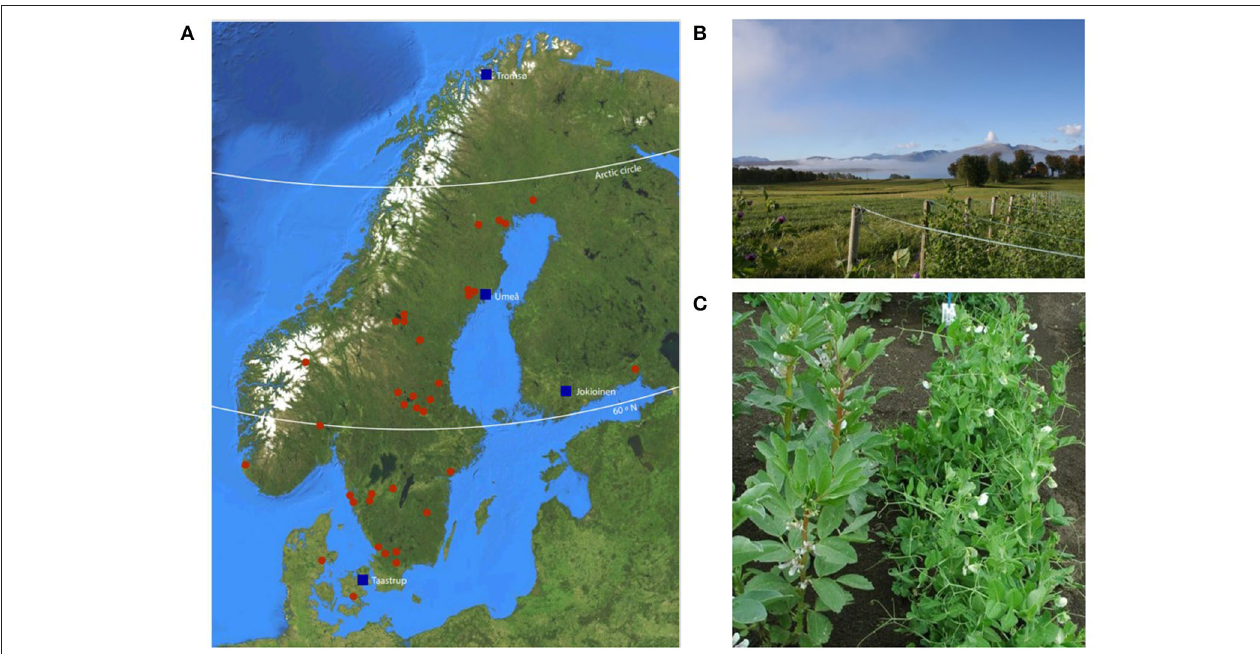
FIGURE 1 | (A) The map of trial sites (blue squares) and landrace accessions with identified locations of origin (red dots). (B) The Tromsø trial site (Norway). Photo by Ulrika Carlson-Nilsson, NordGen, Sweden. (C) The Jokioinen trial site (Finland) where fava beans were used as climbing support. Photograph by Sanna Kulmala, Natural Resources Institute,